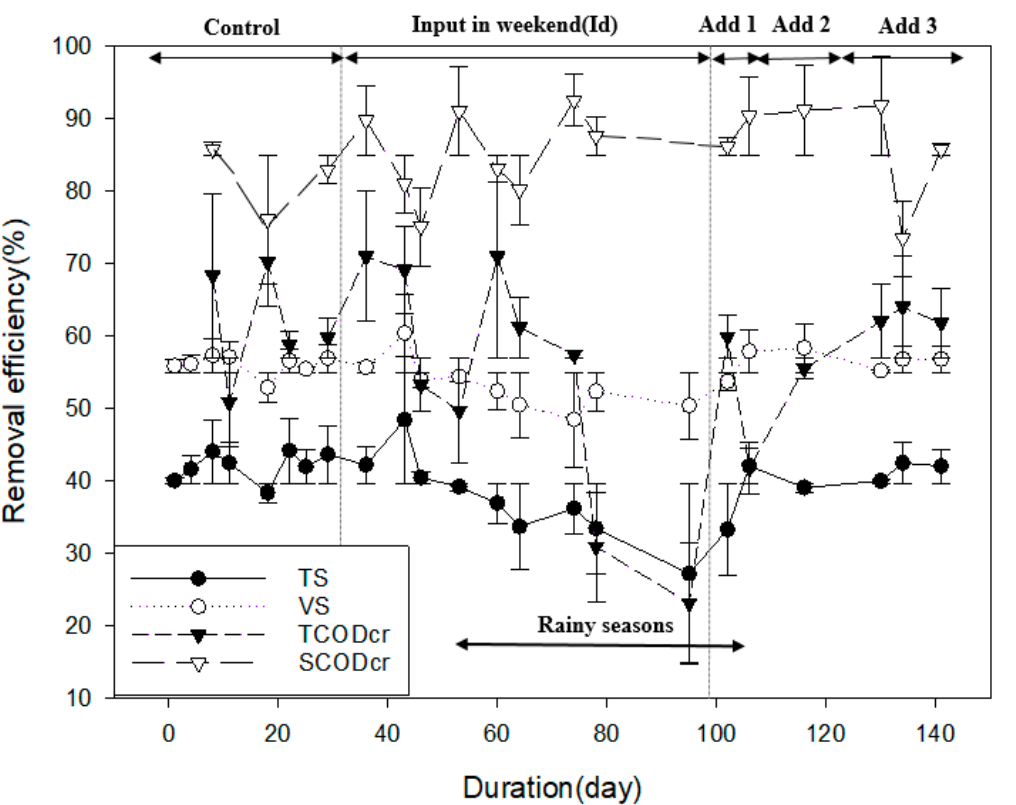
Figure 4. Plot showing the variation in TS and VS efficiency in the experimental period.